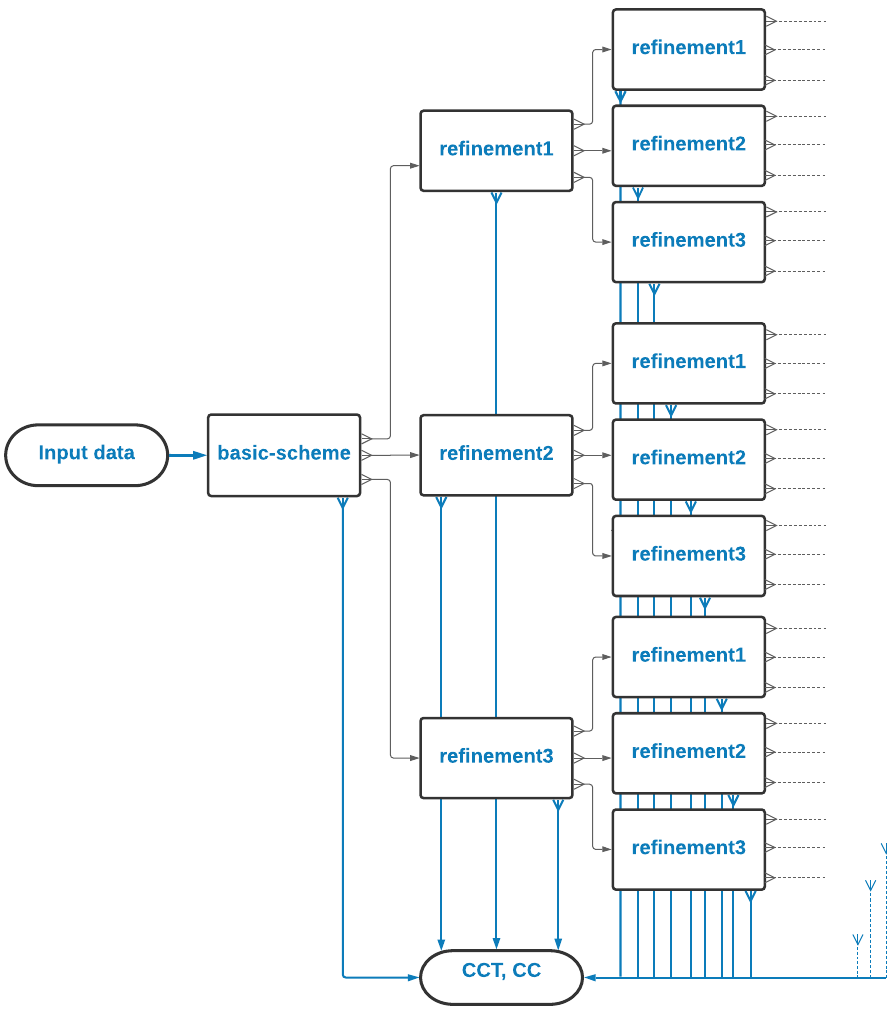
Figure 20. Possible schemes to apply the EEAC concept to make an estimation of the CCT and the